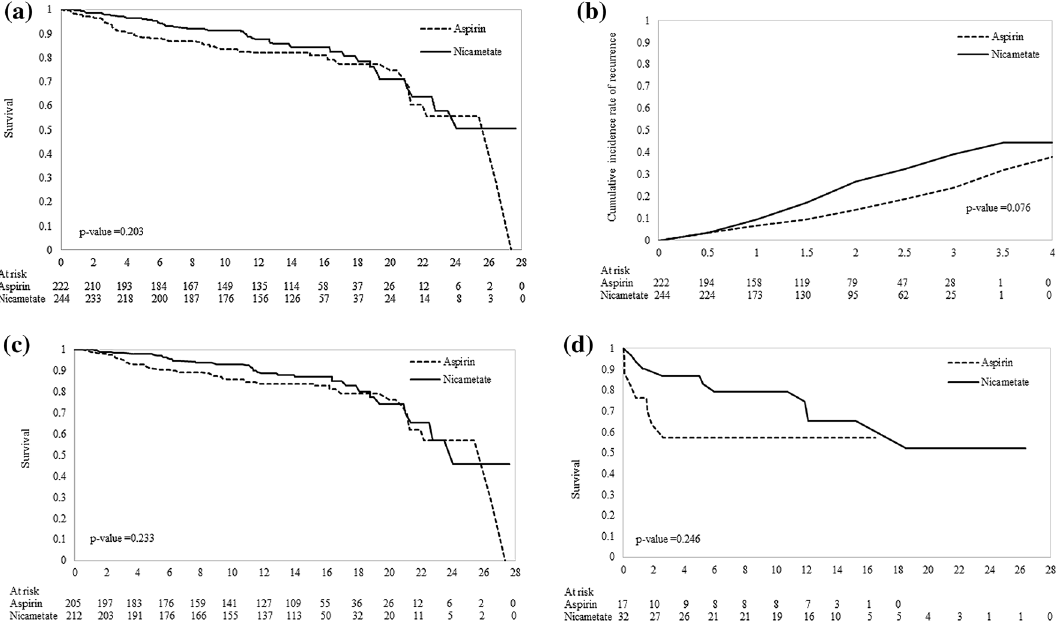
Figure 1. Cumulative survival and risk of recurrence by treatment groups. ( a ) Survival curve by treatment groups. ( b ) Cumulative recurrence rate by treatment groups. ( c ) Survival curve by treatment groups for patients without recurrent stroke. ( d ) Survival curve by treatment groups for patients with recurrent